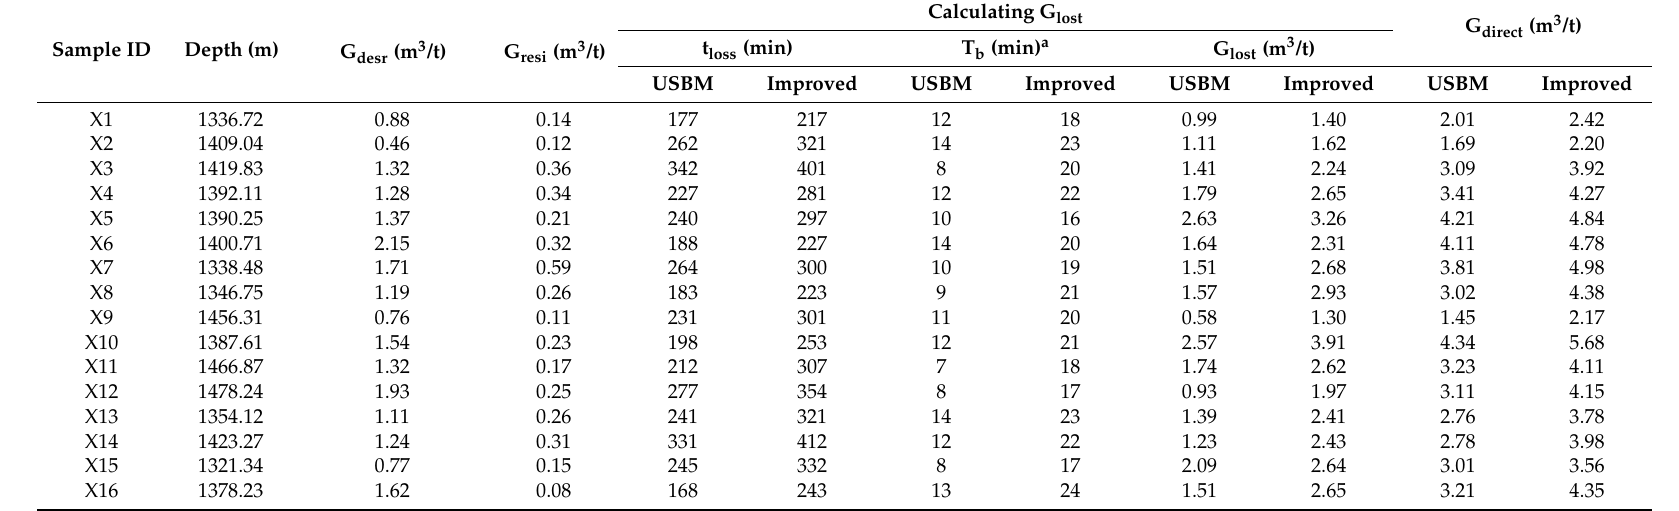
Table 2. The results of shale gas content by the direct